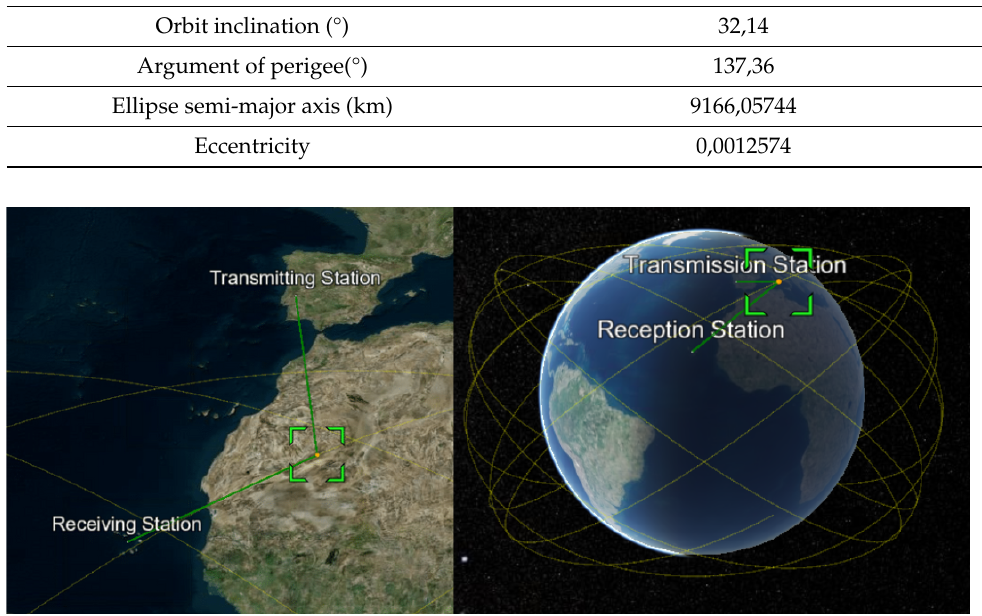
Figure 14. Antennas and satellite positions for the simulated satellite project. Table 11. Path attenuations for the simulated satellite system.